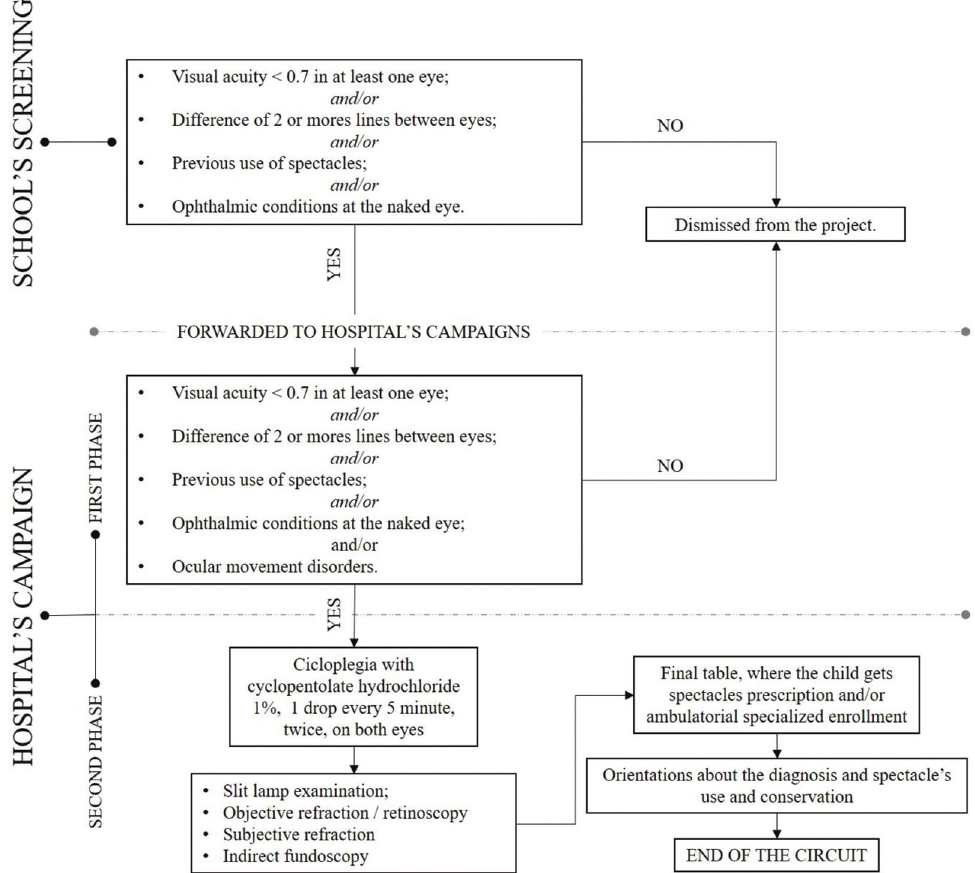
Figure 1 - ‘‘ Vision for the Future ’’ examination circuit in the year